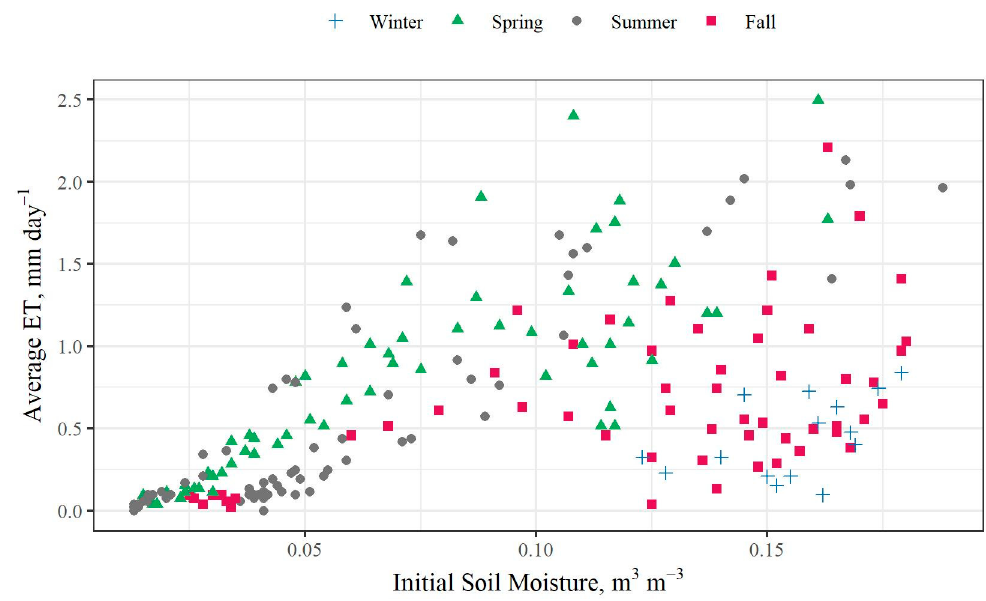
Figure 10. Average daily evapotranspiration relative to daily initial soil moisture on the OnCenter green roof.